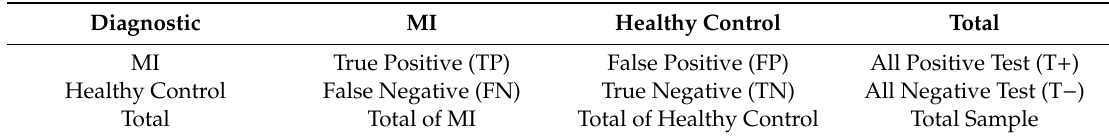
Table 2. The Diagnostic